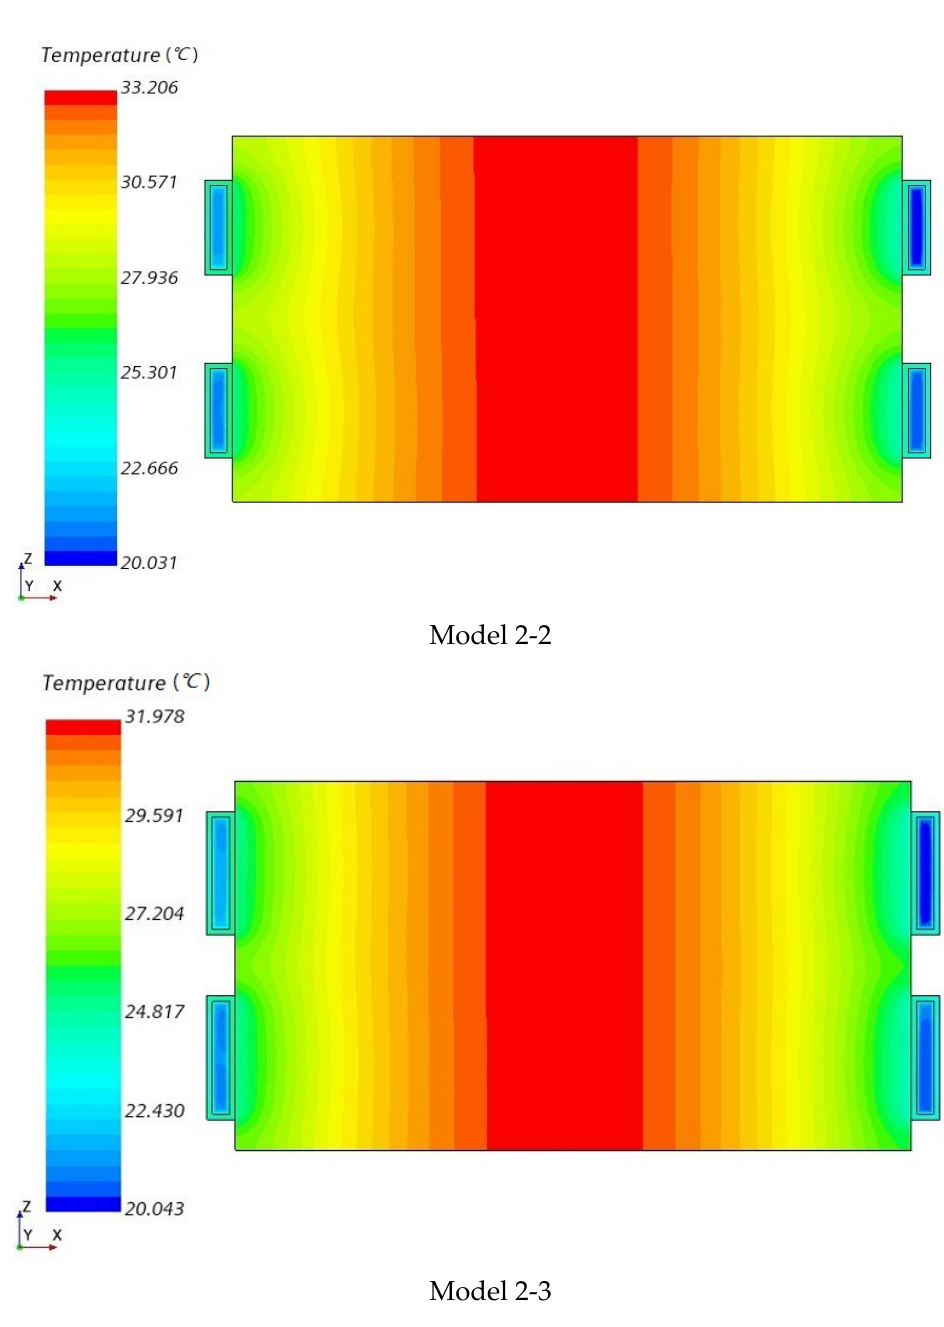
Figure 11. Temperature distributions on the cross-section area of the three modules with the side cooling system.